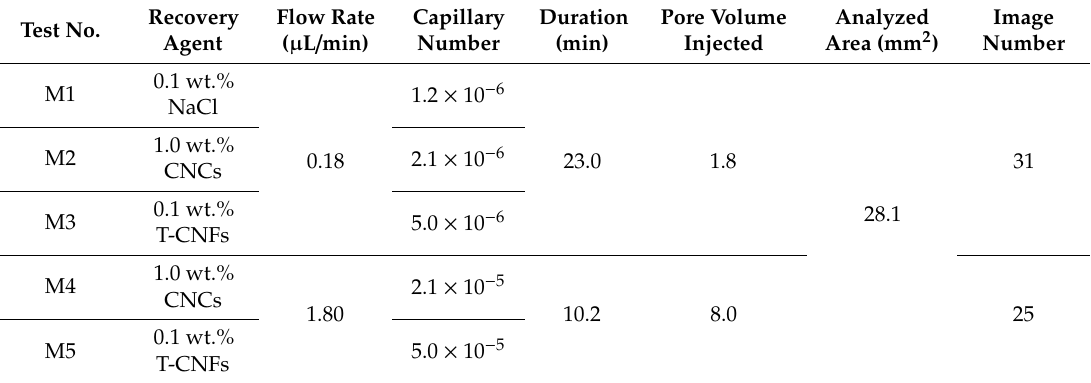
Table 6. Details of injection and image acquisition for microfluidics experiments. Test